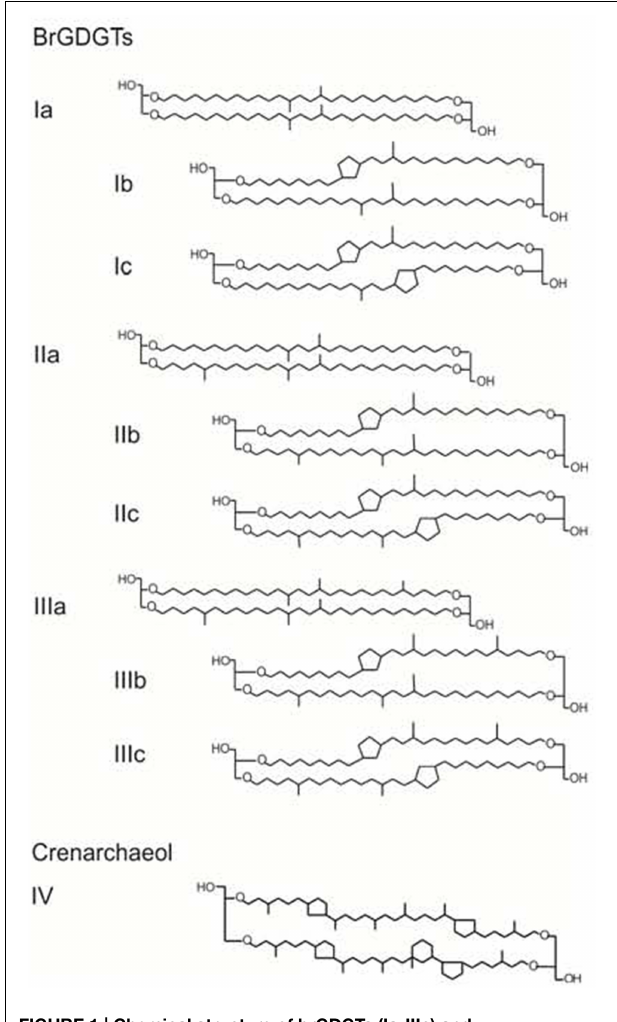
FIGURE 1 | Chemical structure of brGDGTs (Ia-IIIc) and crenarchaeol (IV).